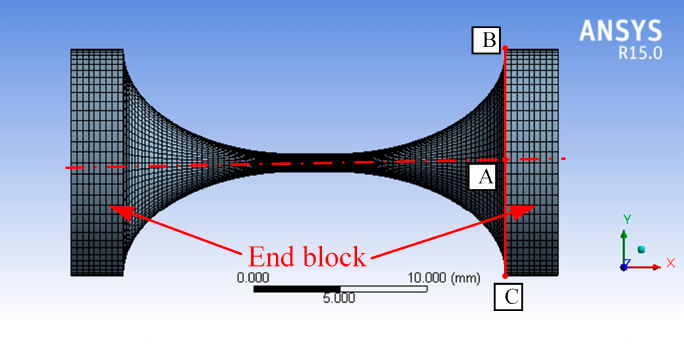
Figure 4. The finite element model of elliptical-arc spherical flexure hinges.